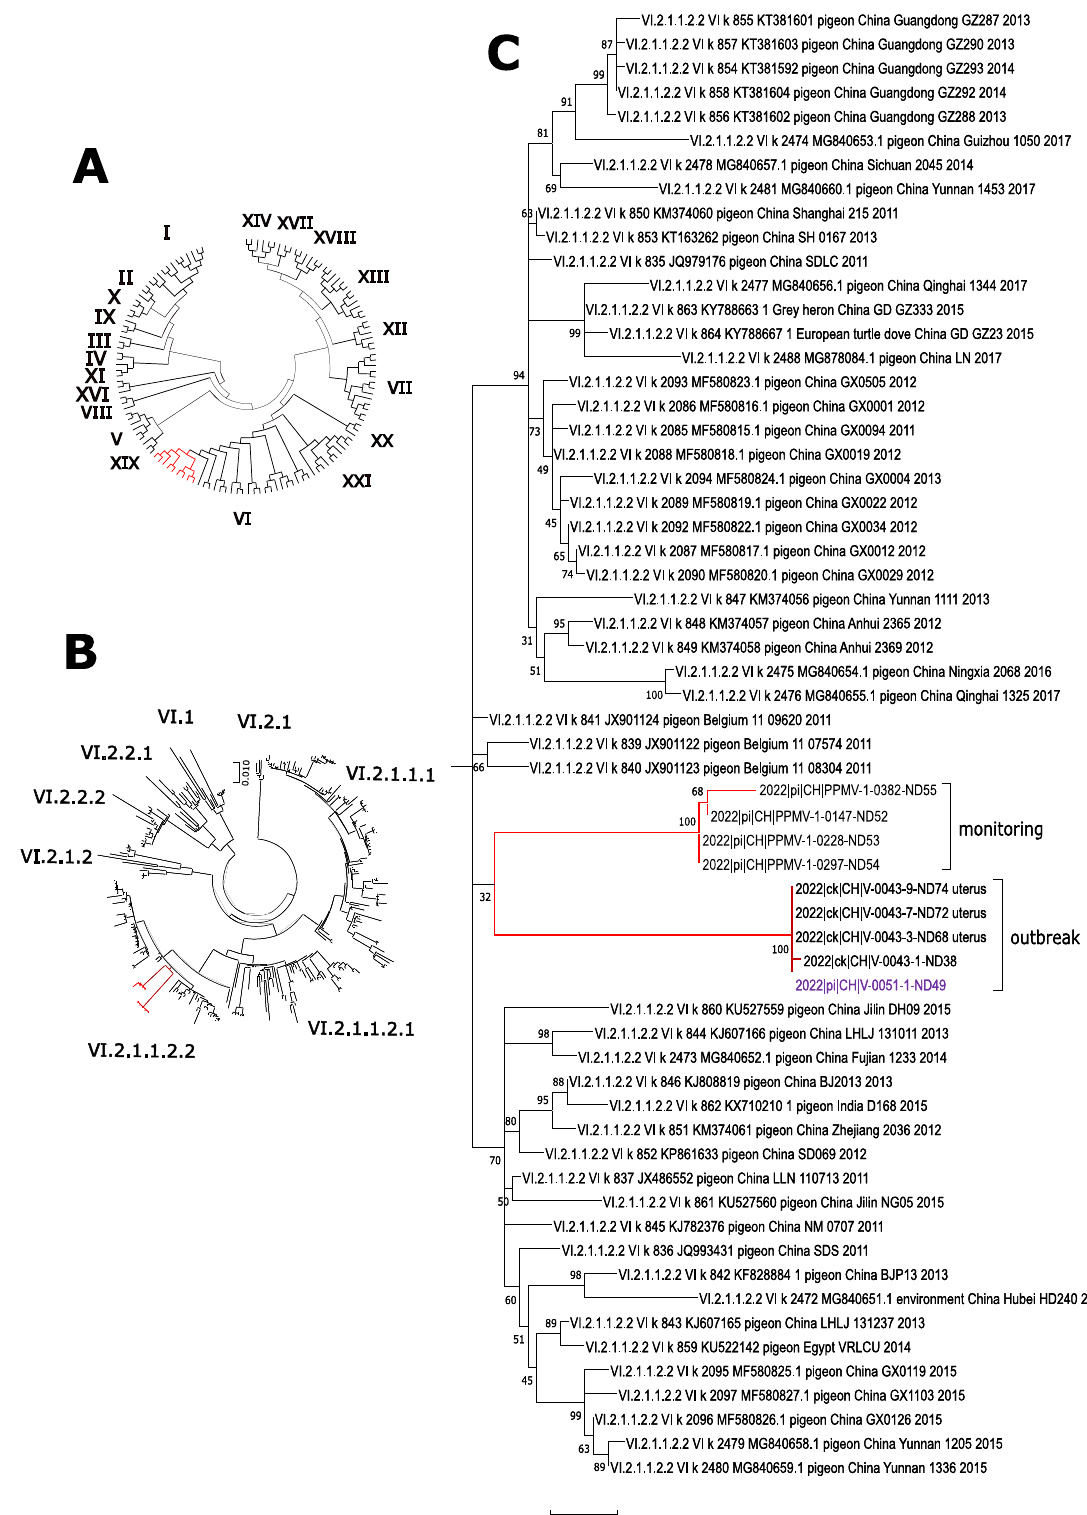
Figure 2. Phylogenetic analysis of detected PPMV-1. Fusion gene sequences obtained from the feral pigeon monitoring programme and from an outbreak in laying hens (indicated by red bars) clustered within genotype VI when analyzed using a pilot collection of all genotypes ( A ). Further analyses with a collection of genotype VI viruses grouped all viruses to subgenotype VI.2.1.1.2.2 ( B ), forming a separate branch within this subgenotype ( C ), closely related to European